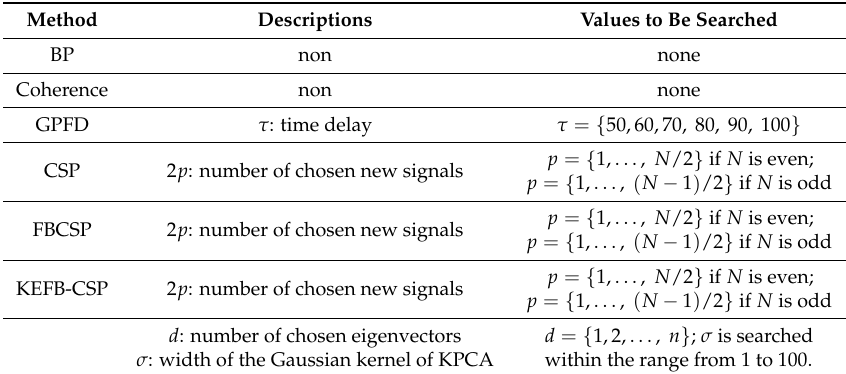
Table 2. Parameters of the feature extraction